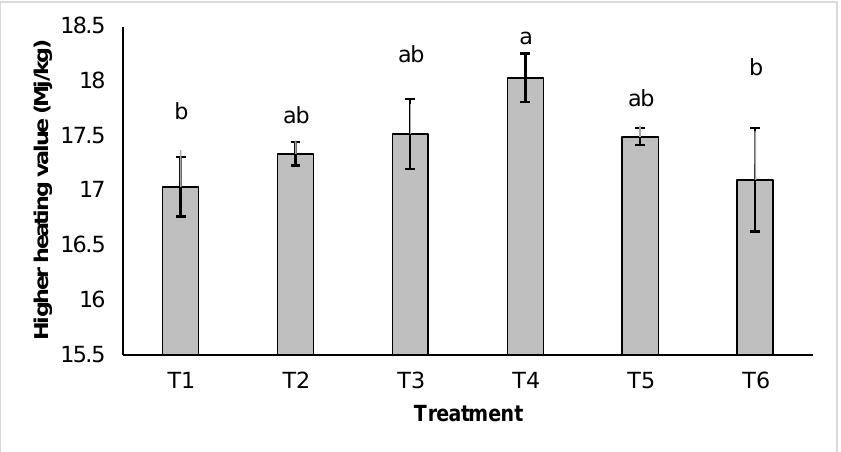
Figure 3. Highest heating value of pellets produced from mixtures of Agave durangensis and Pine spp. sawdust. Different letters indicate statistically significant difference among treatments by Tukey test ( p < 0.05).